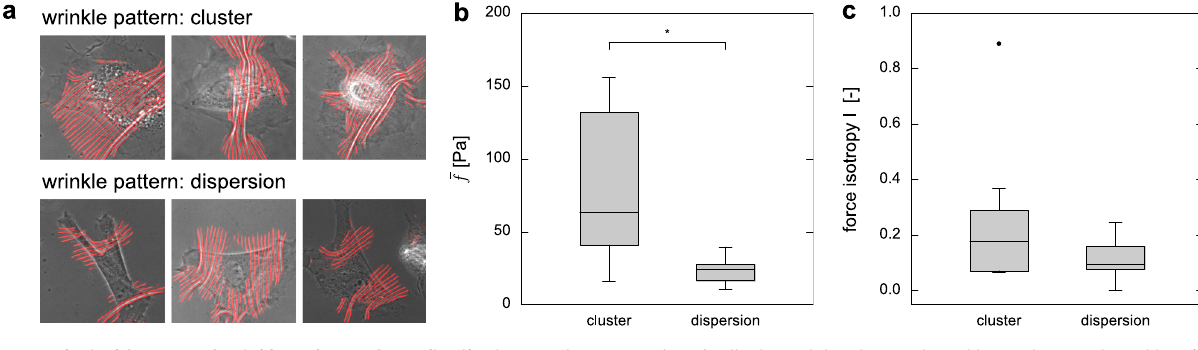
Fig. 4 Topological features of wrinkles relate to force distributions. a Three examples of cells that exhibit clustered wrinkles or dispersed wrinkles. b The average force (cid:1) f and c force isotropy I for two groups of cells; cells that exhibits clustered or dispersed wrinkles. Note that asterisk symbols denote the signi fi cance p < 0.05 (*); two-sided unpaired t -test. The data numbers are n = 9 (cluster) and 25 (dispersion), respectively. The box plots describe minimum, fi rst quartile, meadian, third quartile and maximum. Black dot is an outlier.